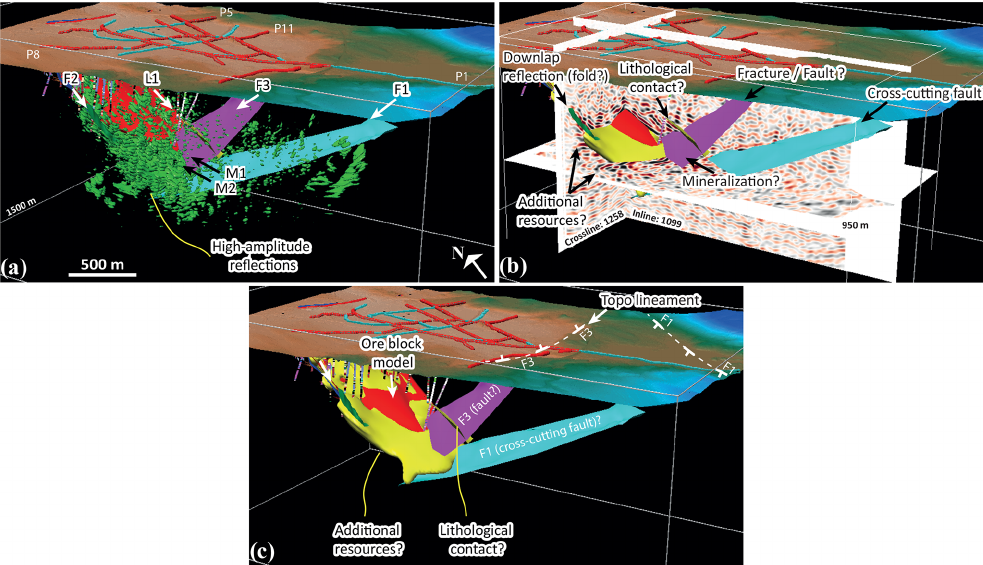
Figure 13. A set of 3D views showing how additional potential resources were identified from the 3D seismic volume. (a) High-amplitude reflections were first extracted through a thresholding procedure as iso-shells (green shells) and then (b) matched with the boreholes inter- secting the mineralization and merged with the ore block model to produce an updated resource model (yellow shell). (c) The refined resource model shows both lateral (to the west) and vertical extension (approximately of 300m) of the ore block model from the available boreholes.